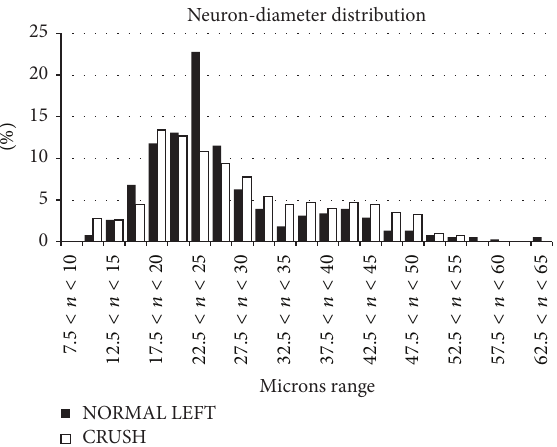
Figure 4: Diameter-frequency distribution of pooled T1 DRG neurons belonging to CRUSH and NORMAL LEFT groups. There is a small rightward shift in diameter-frequency distribution in animals that underwent crush injury.